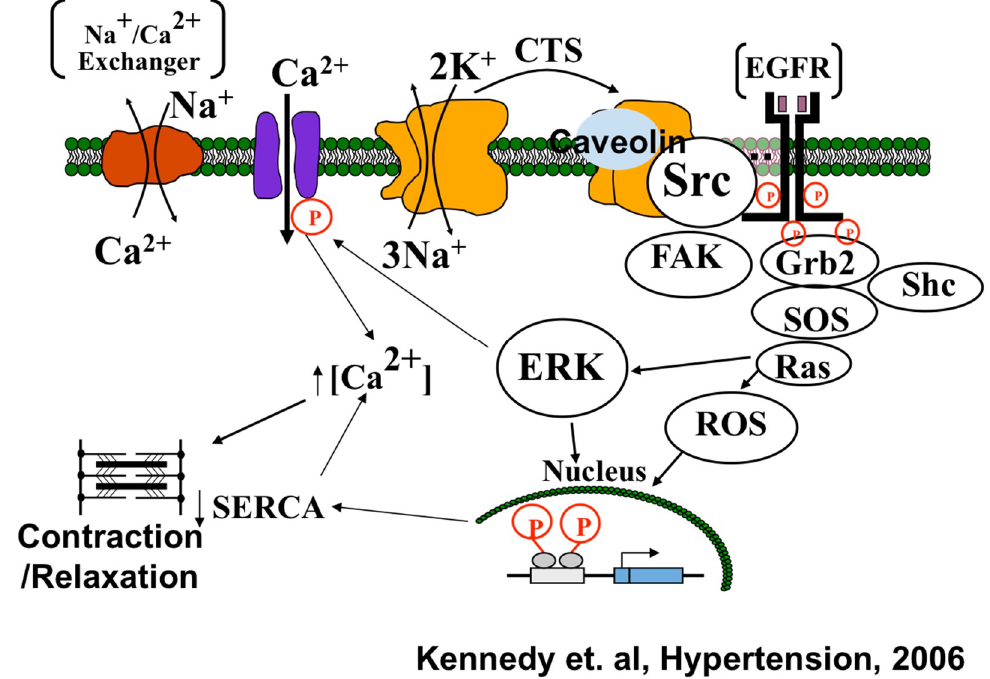
Figure 2. Xie model for Na/K-ATPase signaling showing Na/K-ATPase (orange proteins) serving as scaffolding protein in caveolae regulating the tyrosine kinase activity of Src. Na/K-ATPase can act as a specific receptor for CTS and as a non-specific receptor for ROS. As this signal cascade generates ROS, the Na/K-ATPase-Src cascade can serve as a feed forward amplifier for ROS. Source: Kennedy et al. (2006)